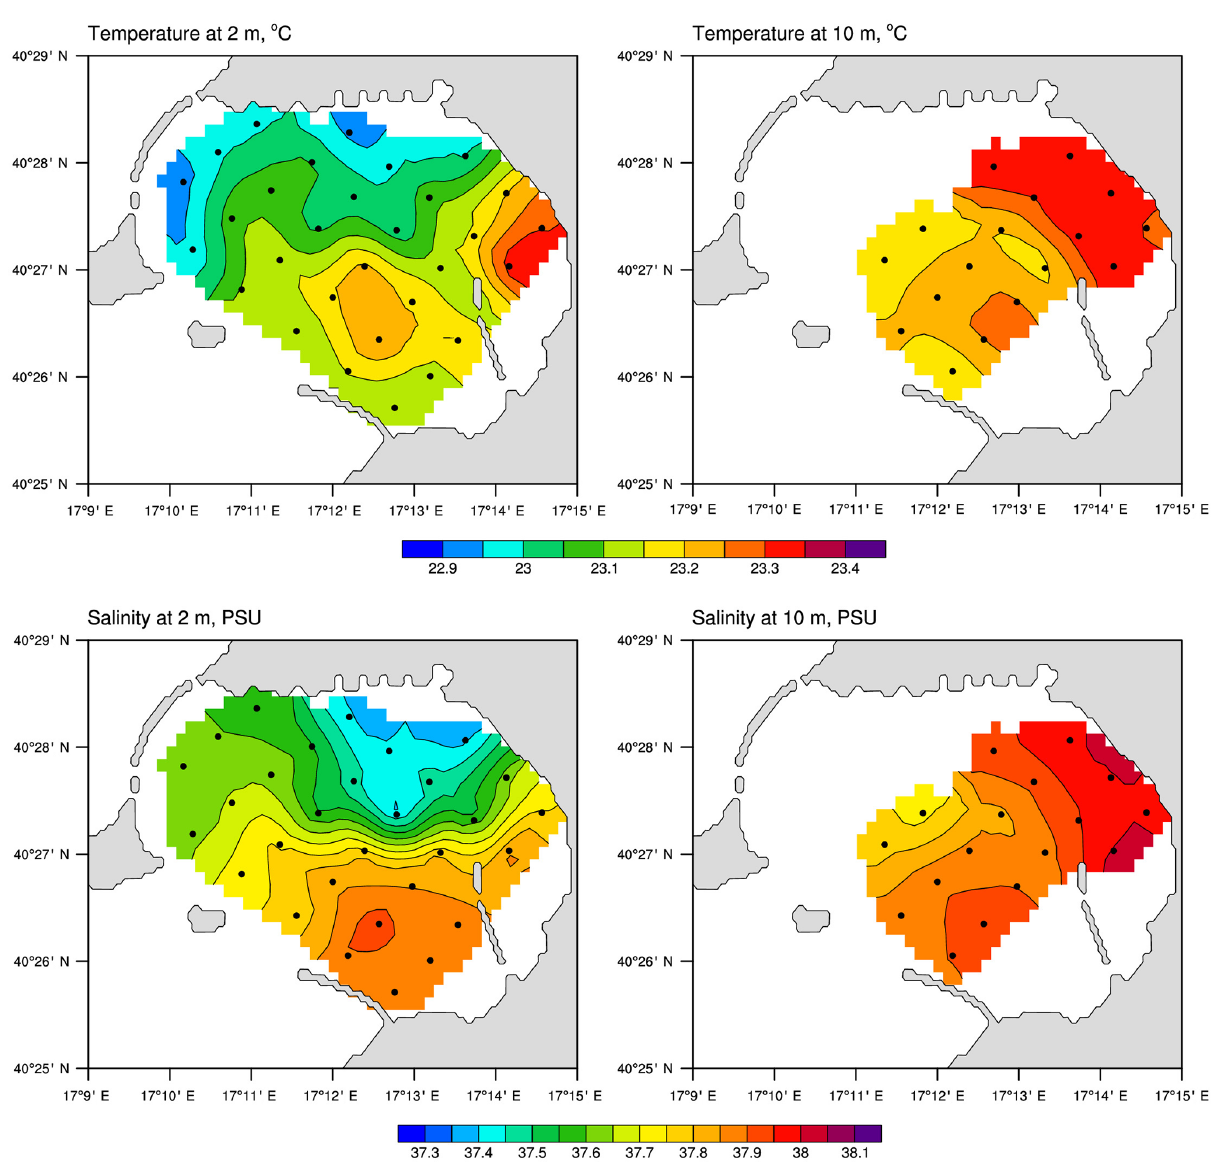
Figure 13. Mar Grande near-surface (2m) and near-bottom (10m) mapping of temperature and salinity fields for 5 October